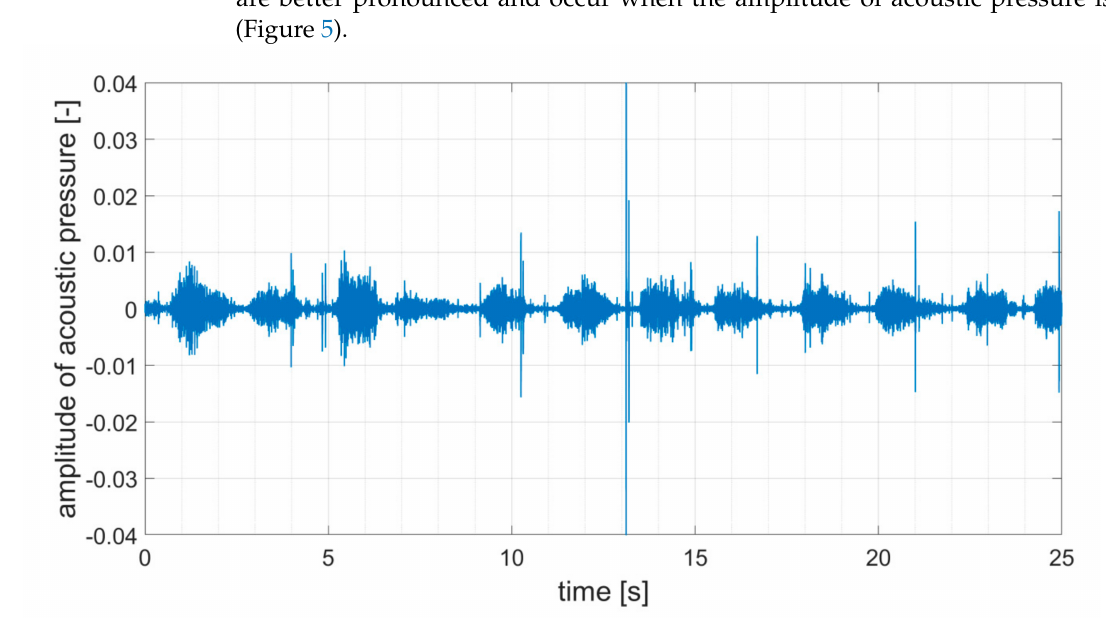
Figure 5. Respiratory sound filtered using high-pass (500 Hz) and low-pass filter (1600 Hz)-for the same healthy person as in the Figure 3 (Patient No. 1). The changes of the respiratory phases are expected at the regions with the minimum amplitude of acoustic pressure. An example of the noise caused by the equipment manipulation is well demonstrated at the time of 13 s.